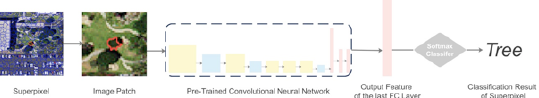
Figure 4. Framework of proposed per-superpixel MCNN method (taking the recognition of tree as